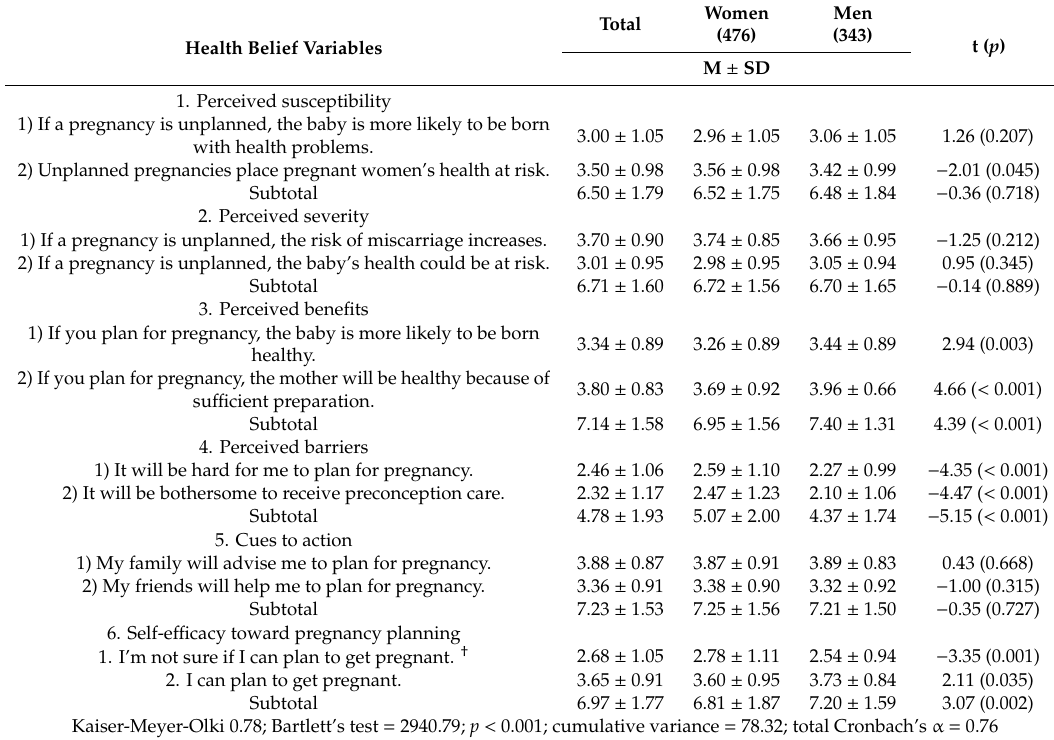
Table 3. Health beliefs related to pregnancy planning and self-e ffi cacy toward pregnancy planning by gender ( n =